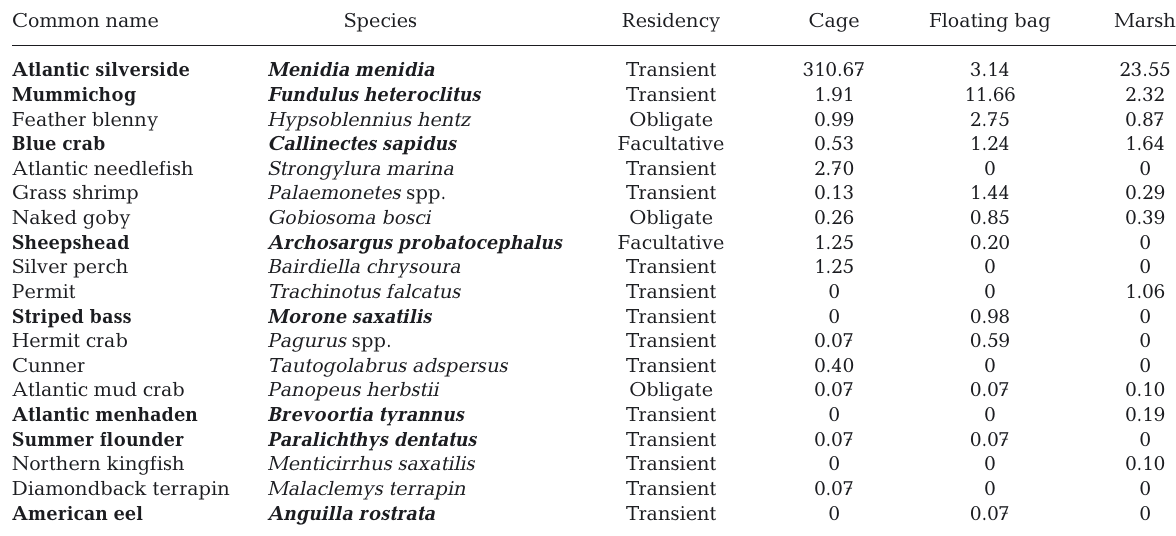
Table 1. Summary of species observed in video footage. The number of raw observations per hour of viewable footage col- lected across sampling dates is shown. Species listed in bold are part of a commercial or recreational fishery in New Jersey. Classification of species by residency type is sourced from Breitburg (1998) and Coen et al.